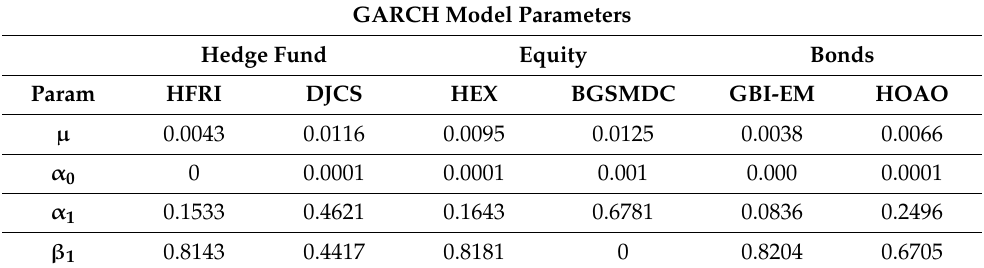
Table 5. GARCH parameters. Source: authors.